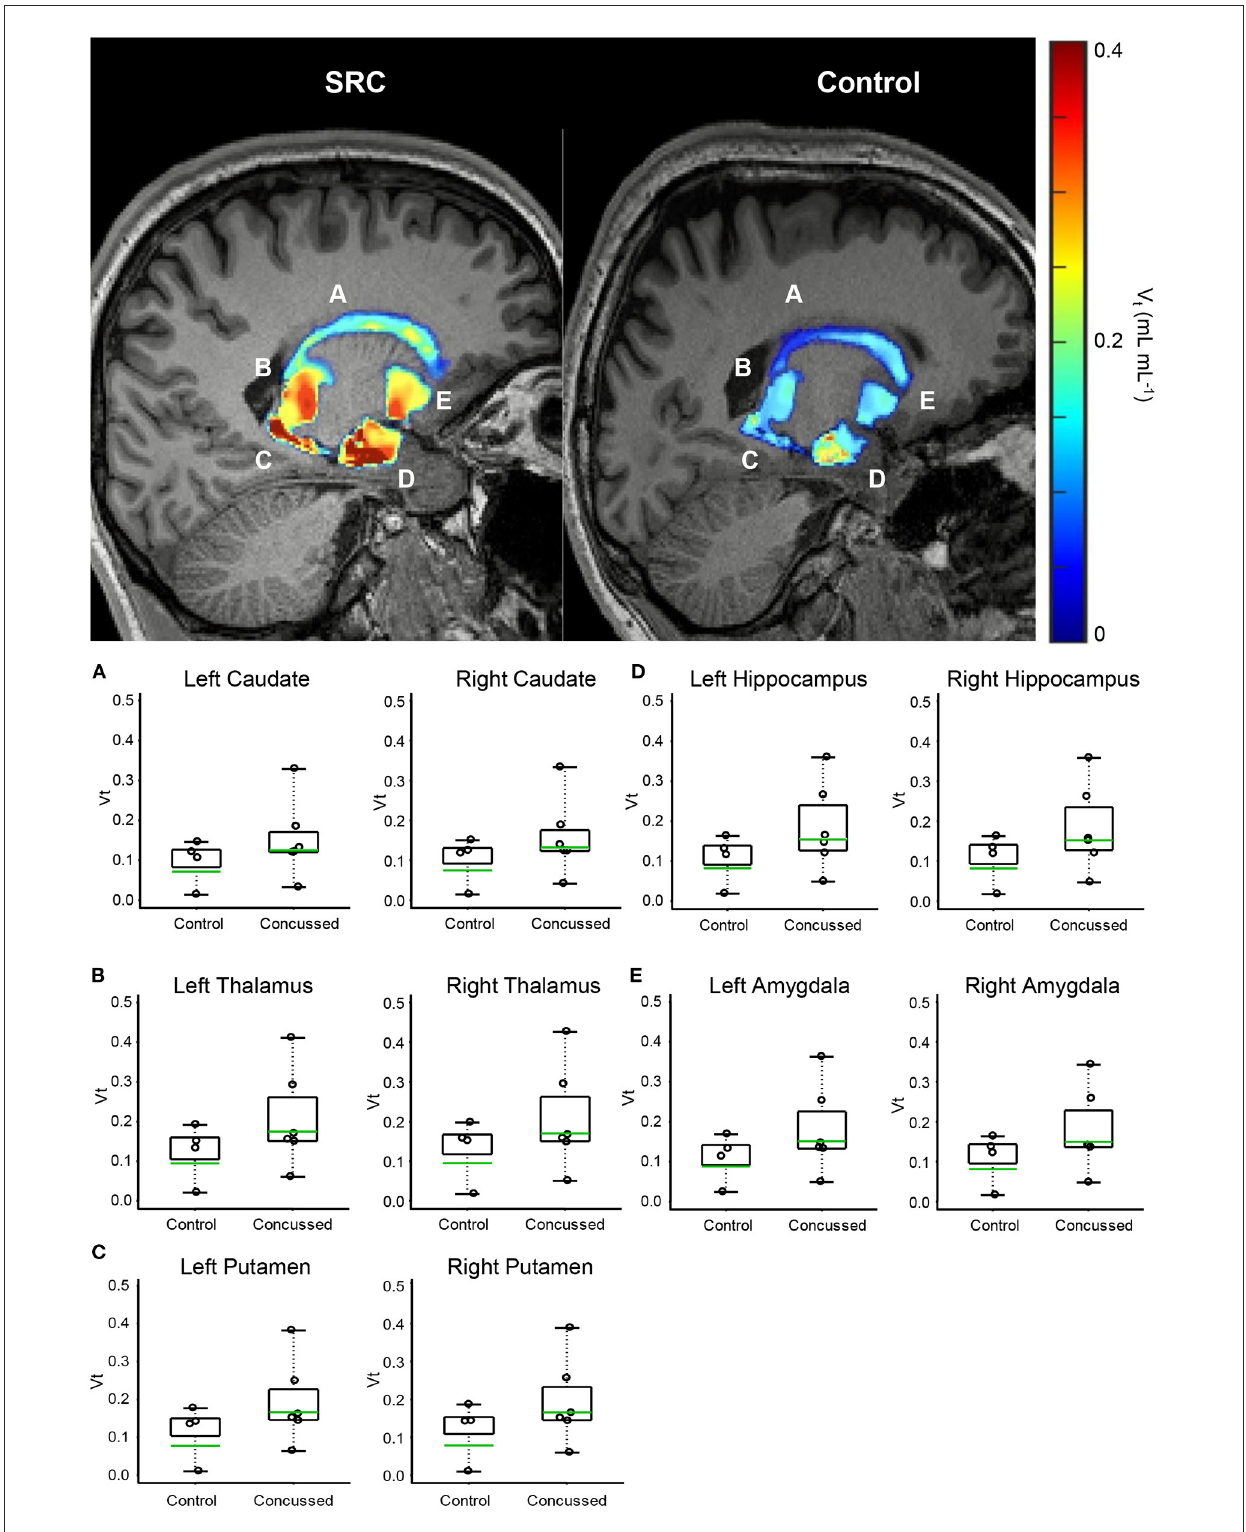
FIGURE1 Volumetric VT maps quantify persistent microglial activation in athletes diagnosed with SC (Group 1) who have achieved uRTP compared to controls (Group 2). (A) Caudate. (B) Thalamus. (C) Putamen. (D) Hippocampus. (E) Amygdala. Regional VT maps are computed (top) from a voxel-based parametric PET map. Geometric means (bottom-green line) of voxels within each CNS region are compared (bottom) between SC athletes and age- and genotype-matched healthy controls. Across 164 regions, the regions associated with consistent and significantly elevated microglial activation are the bilateral caudate, thalamus, putamen, hippocampus, and